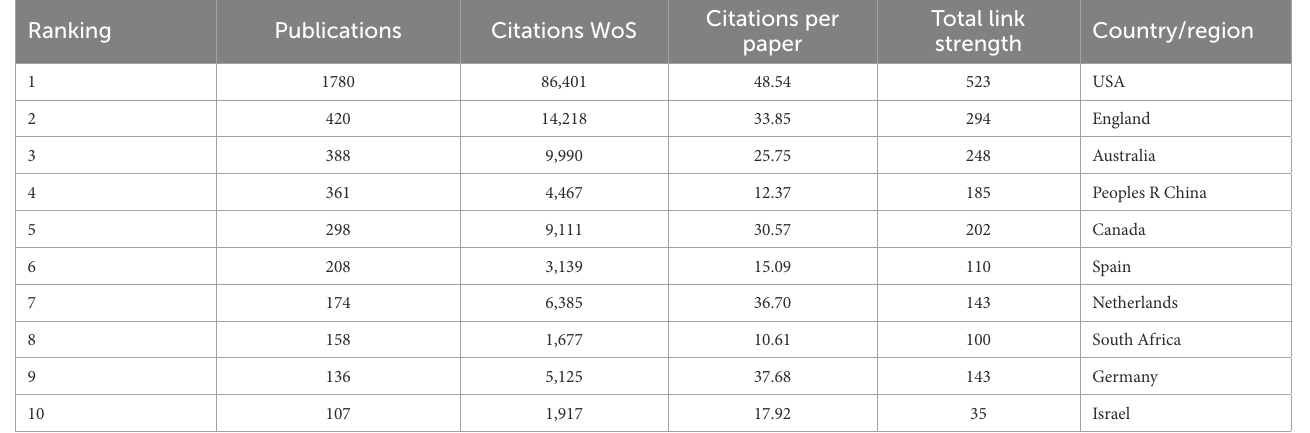
TABLE 1 Top 10 prolific countries/regions researching positive psychology. Ranking Publications Citations WoS